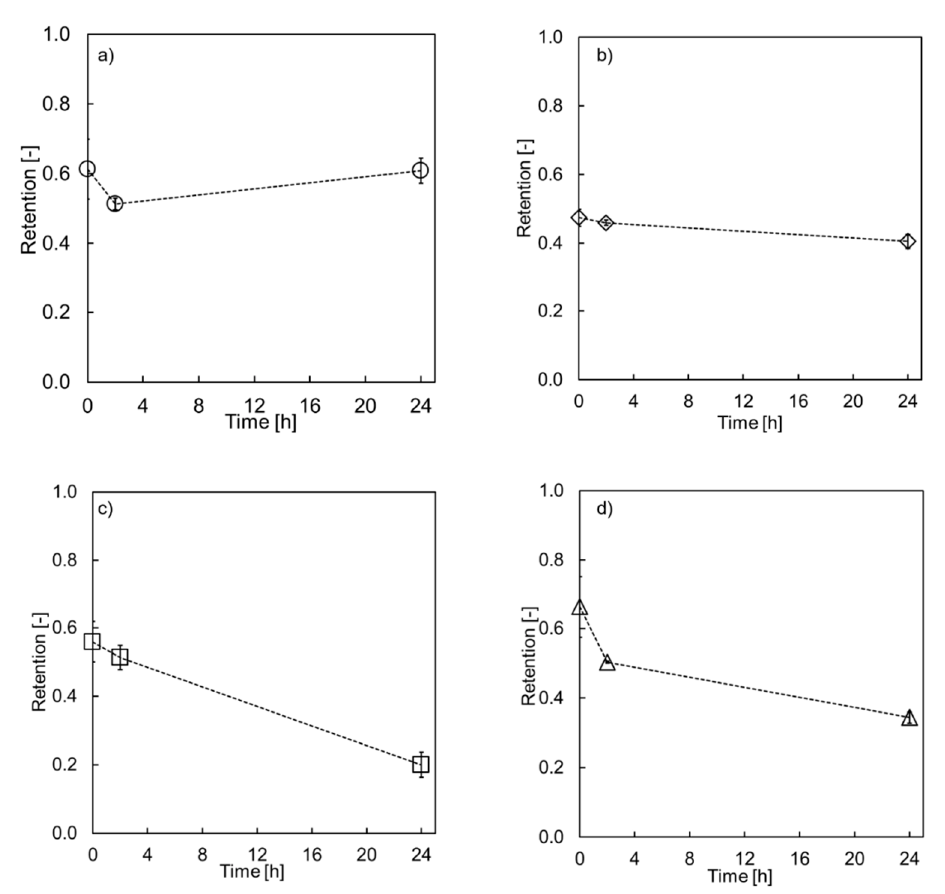
Figure 2. Mg retention values of immersed membranes in 15% H 3 PO 4 ( a ) PES (PDADMAC/PSS) 4 , ( b ) PES (PDADMAC/PSS) 8 ( c ) sPES (PDADMAC/PSS) 4 ( d ) sPES (PDADMAC/PSS) 8 as a function of immersion time.